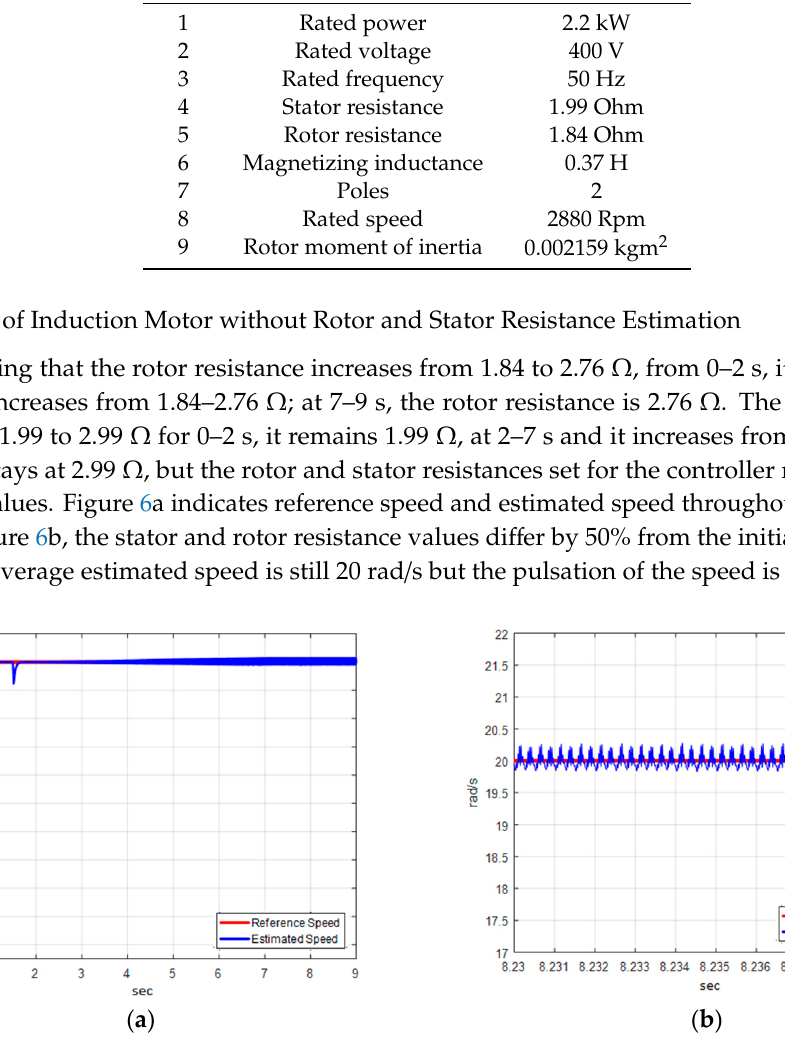
Figure 6. Speed of induction motor without online rotor ( a ) and stator resistance ( b ) estimation: reference speed, real speed and estimated speed.